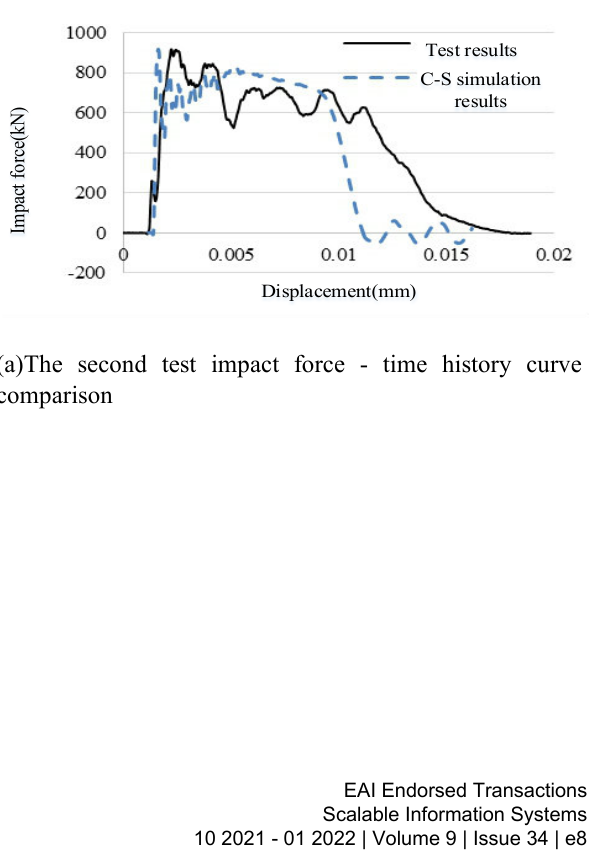
Figure 12. Anti-climber deformation